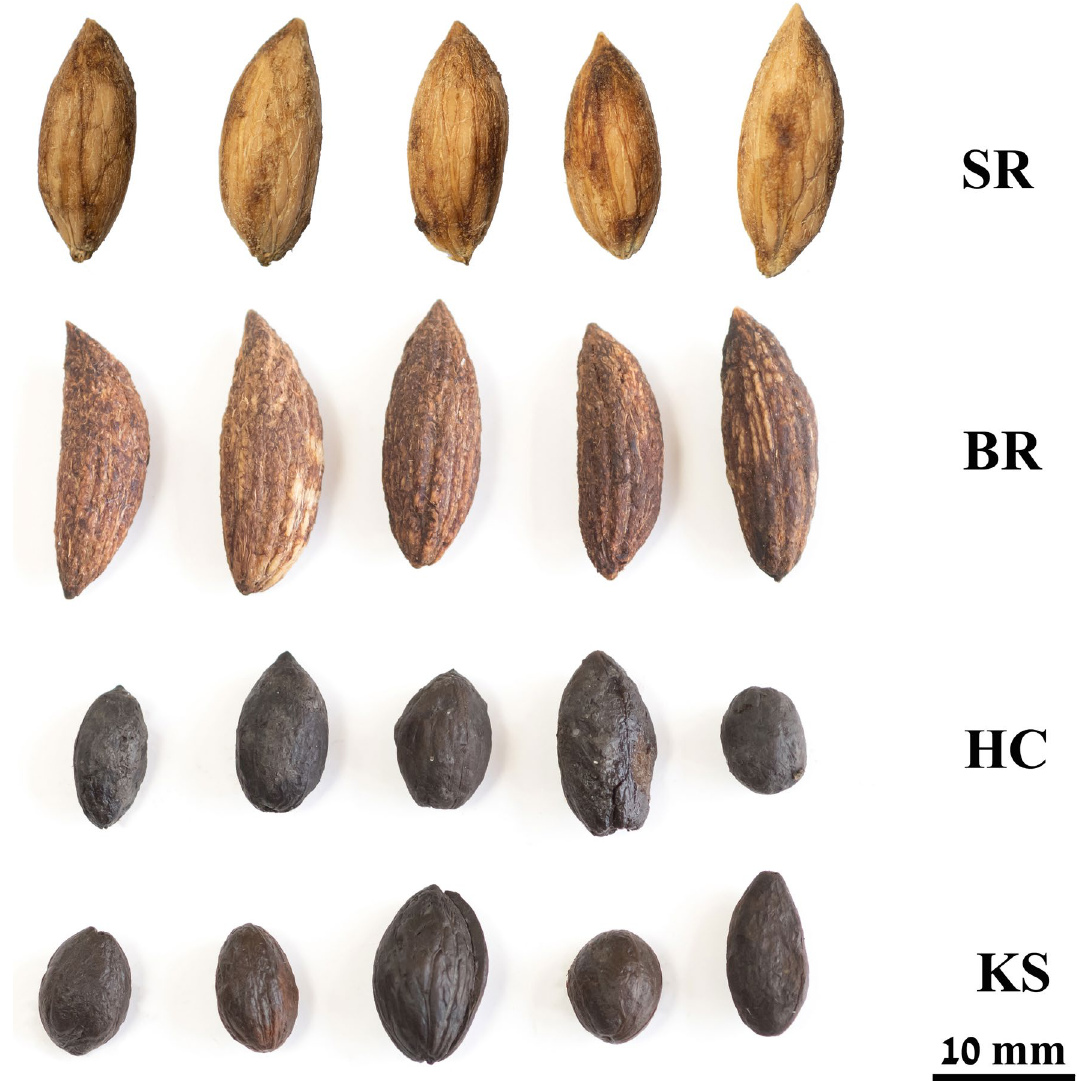
Figure 6. Representative olive pits of the reference cultivar Barnea (BR) and Souri (SR) and ancient pits from Hishuley Carmel (HC) and Kfar Samir (KS), showing the uniformity of the cultivars vs. variability in the structure and size of the archaeological olive pits (Photos: top lines-T. Nachshon-Dag,-bottom lines-O. high tide was 0.3 m above ILSD. Two layers of overlapping stones made up the bottom paving (Fig. 4b, c). The fill was ~ 15–20 cm thick and comprised of a dense layer of olive pits, overlain by grey soft clay with fewer pits. Eight of the standing stones used to build the installations were kurkar (calcareous-cemented quartz sandstone of aeolian origin), two each of limestone and beachrock. One of the paving stones is kurkar and one of limestone (SI Appendix 2). All are local stones occurring within a few hundred meters of the site. Kurkar was probably quarried on the coastal ridge, limestone originated from Mount Carmel, or from the nearby Ahuza and Galim streams. The beachrock used was identified as belonging to MIS 5e (dated to ~ 125,000–120,000 years BP) and occurs in several locations on the northern Carmel coast 40 . The two structures reflect a high degree of investment in their construction. Although they were built from a variety of local stones that apparently had not been chosen for a specific natural quality, they seem to have been selected for their shape (flatness) and similar size. Moreover, the dimensions of the installations are similar and they had both been paved with stones and probabely had cover-stones. These factors imply that the structures were constructed with care to protect their contents, even though they were not air or watertight. Olive pits from the two structures at Hishuley Carmel were dated by radiocarbon (for details see SI Appendi- ces 3a–c). Together, the dates place the oval structures in the mid-7th millennium BP (6,656–6,450 BP), i.e., the Middle Chalcolithic period. This makes them slightly later than the Kfar Samir olive-oil production assemblage, which was radiocarbon dated to ca. 7,000 BP (SI Appendix 3c: Fig. 1) 37.